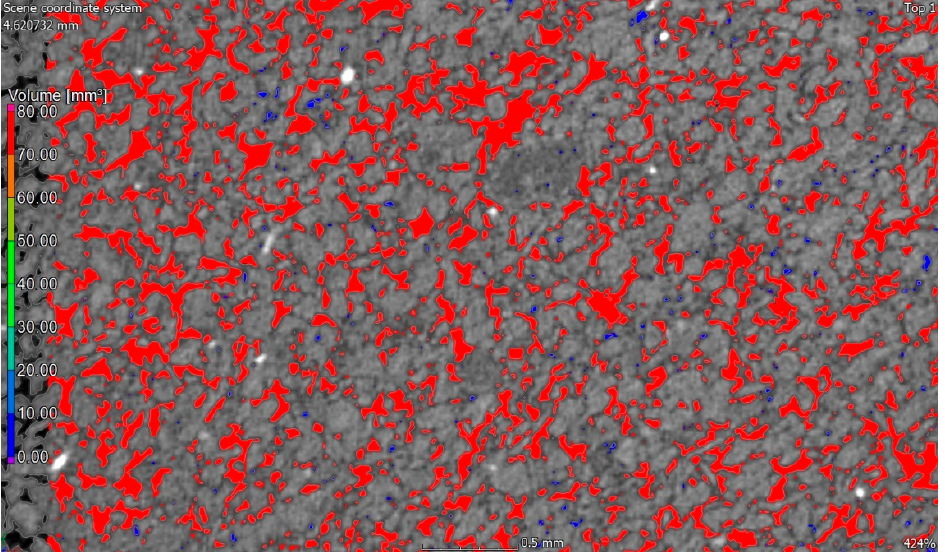
Figure 14. Image of the porosity of the silicone material made by CT. The diagram shows the layout and structure of the pores.